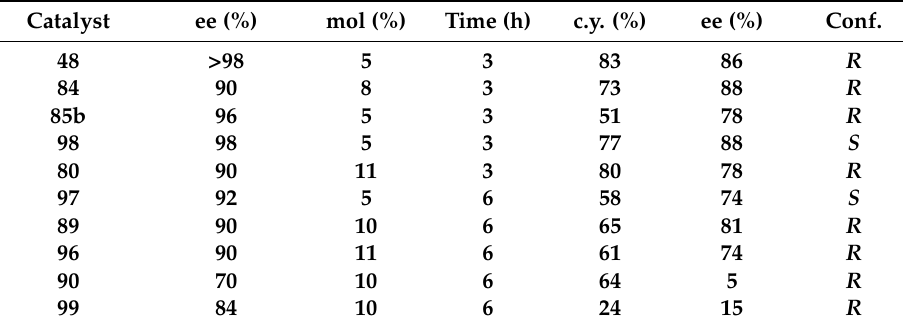
Table 7. Catalyst variation in the alkylation of benzaldehyde with ZnEt 2 [82].